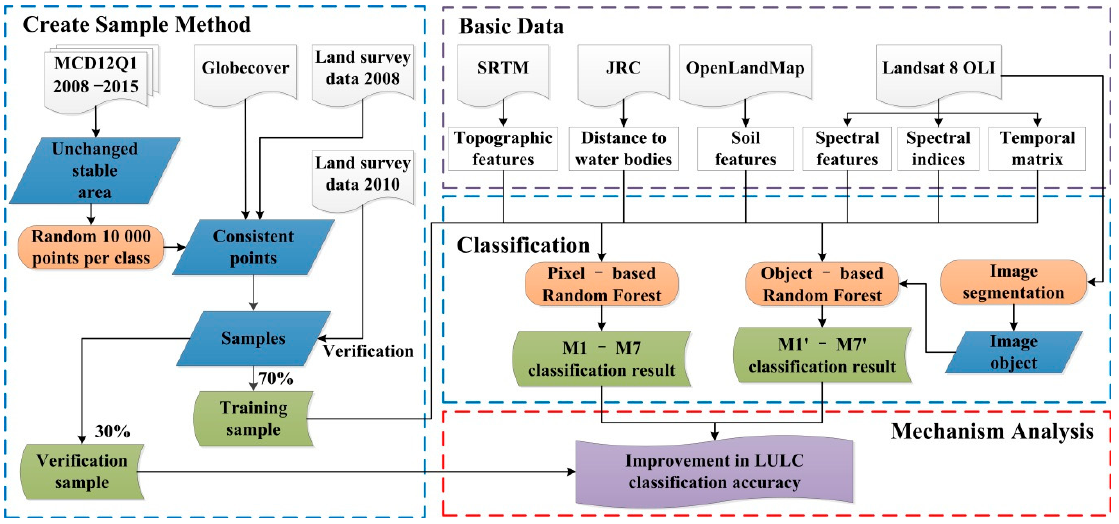
Figure 3. Flowchart describing the data processing and analysis steps, including sample selection, image segmentation, random forest (RF) classification, classification accuracy assessment, and mechanism analysis.